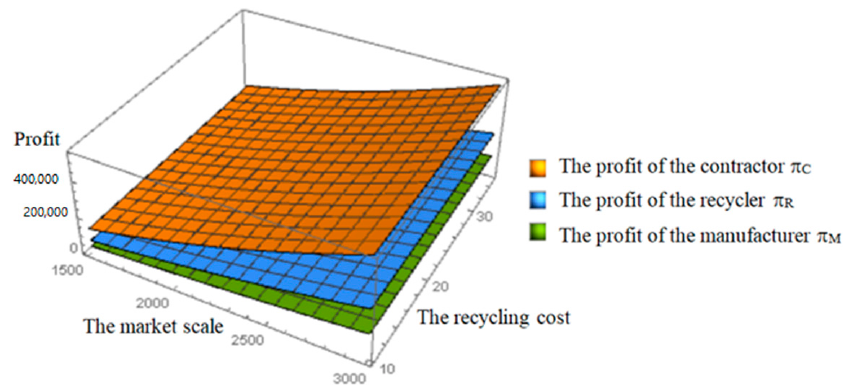
Figure 6. Effects of the market scale and the recycling cost on the profits.